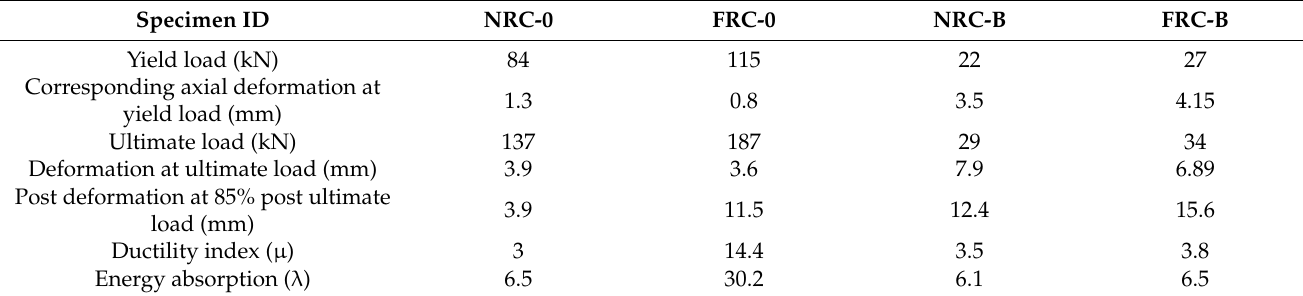
Table 4. Loading test results and ductility for columns and